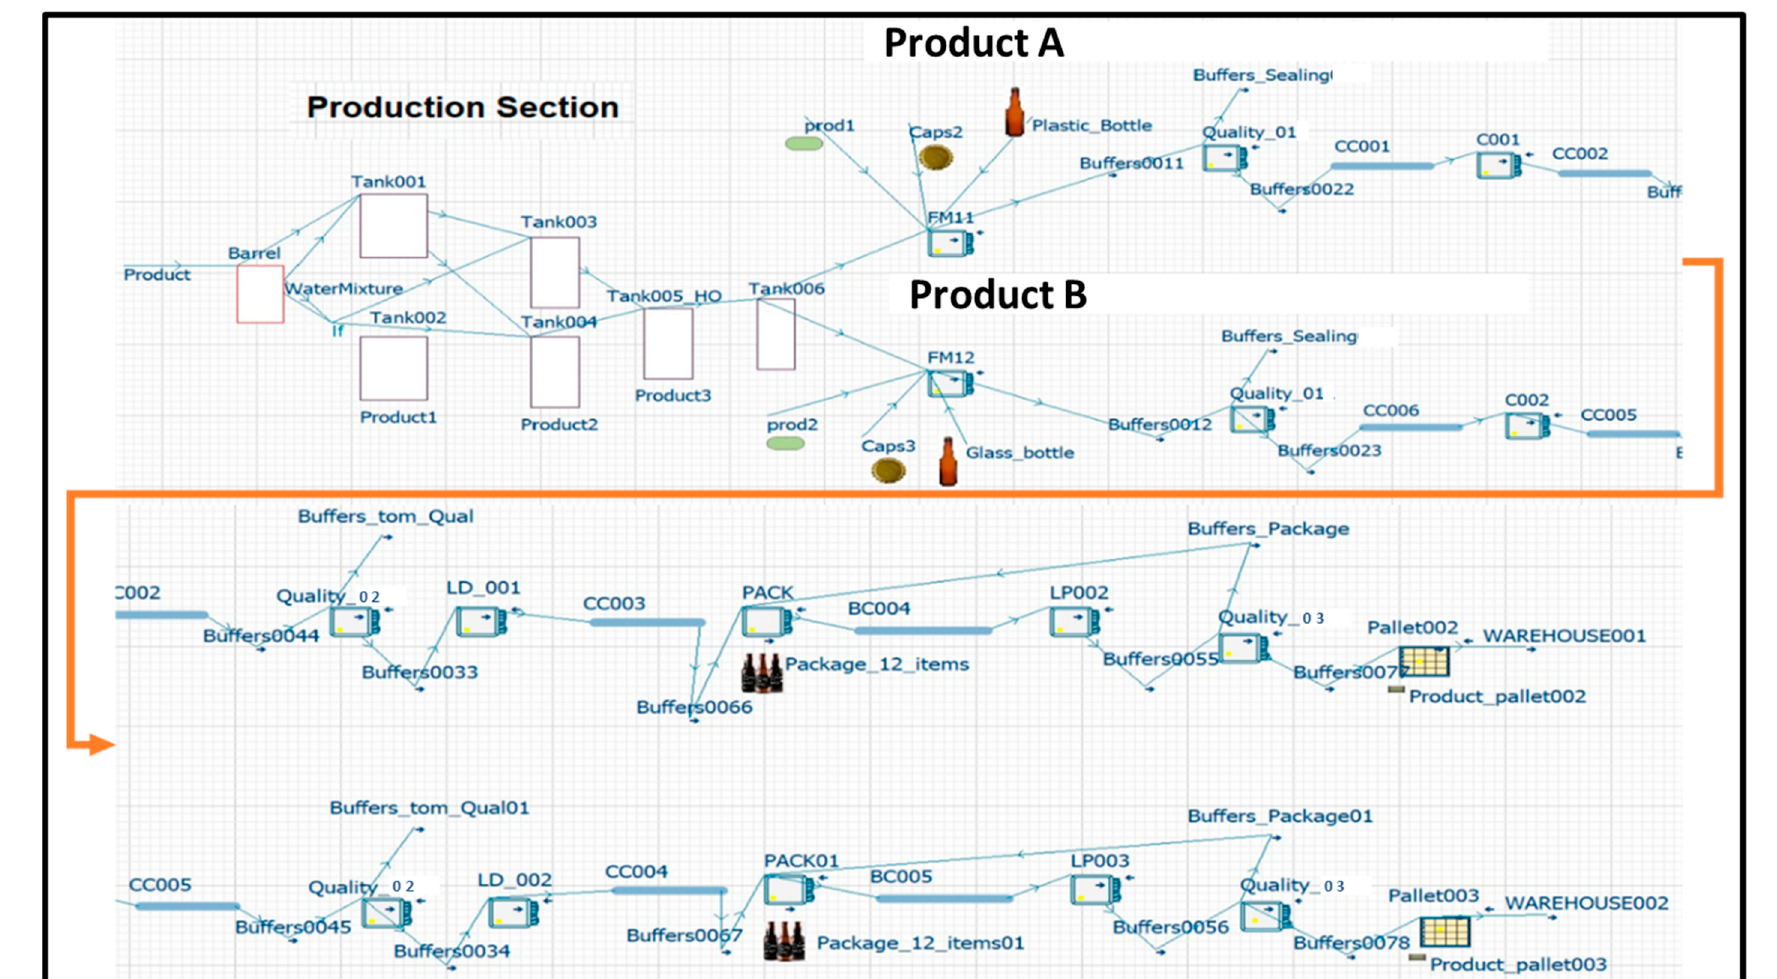
Figure 10. Digital Model of the Production Line in the WITNESS simulation environment.